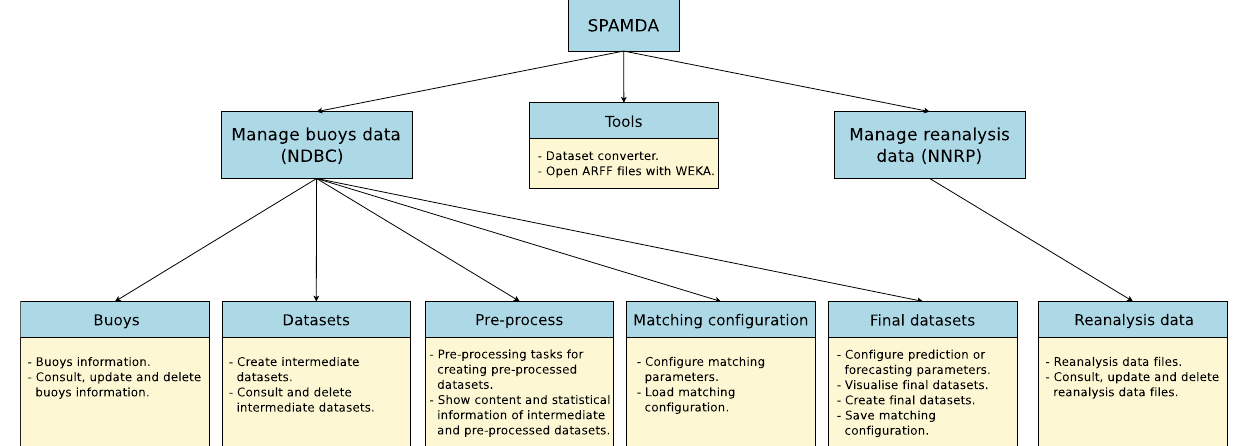
Figure 3. Brief outline of the functionality provided by